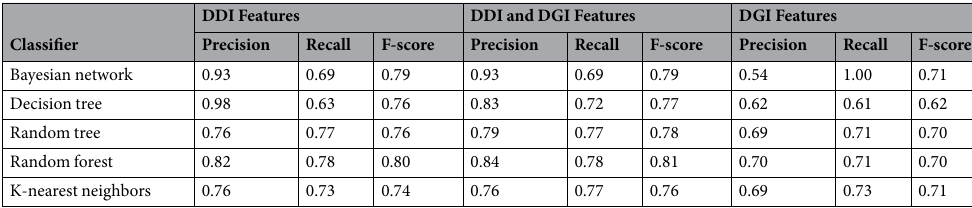
Table 2. DDI Prediction comparison on DDI corpus training